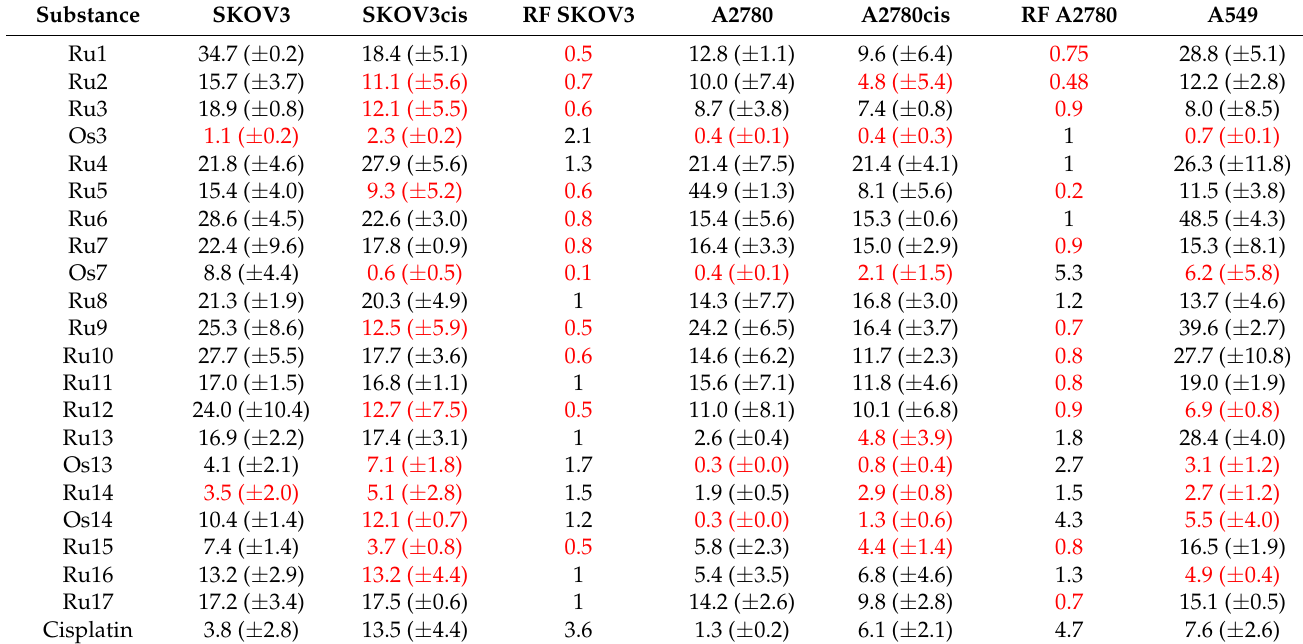
Table 3. IC50 [ µ M] and resistance factors (RF) of all metal(II) compounds for cancer cells *.